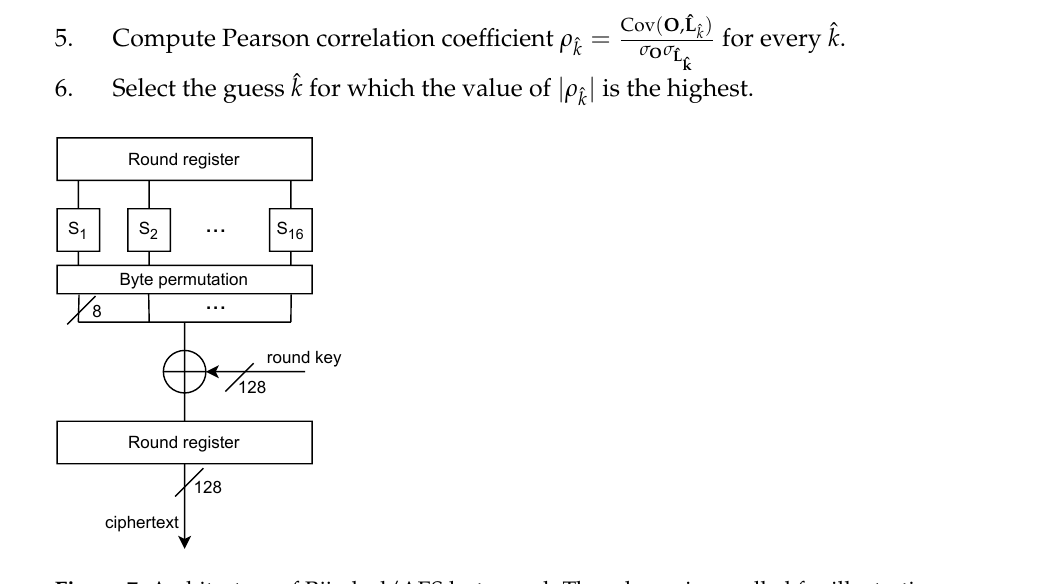
Figure 7. Architecture of Rijndael/AES last round. The scheme is unrolled for illustration purposes only; both “round register” blocks depict the same hardware